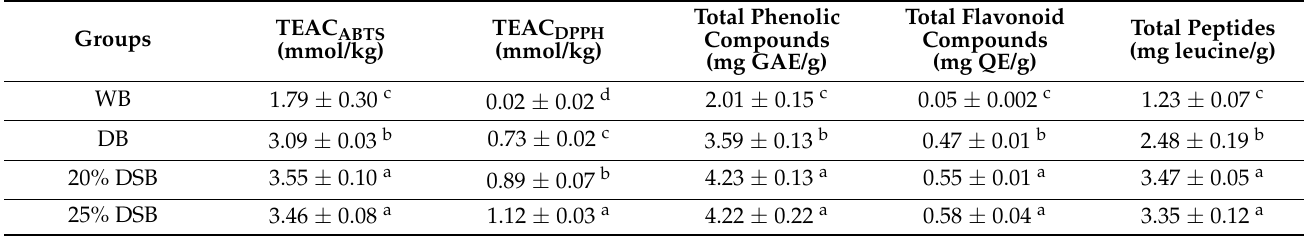
Table 4. Bioactive content of the different bread